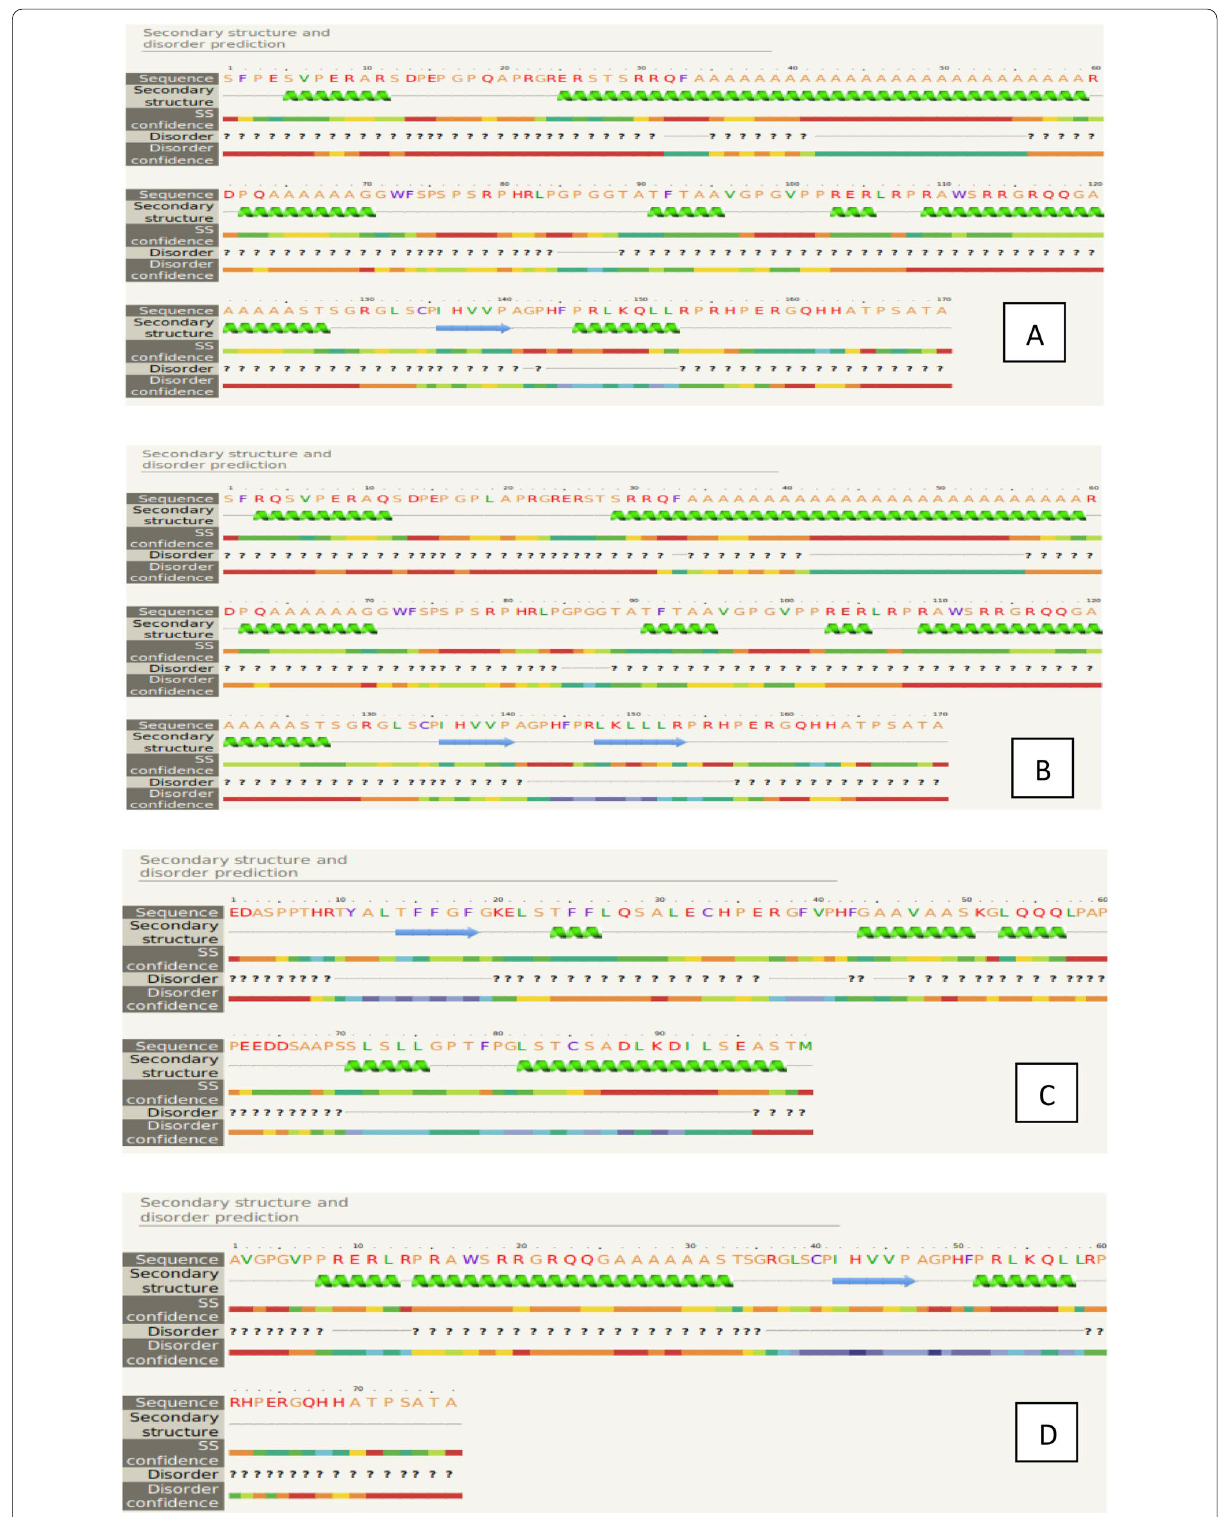
Fig. 4 Secondary structure change in protein in PCOS patients in comparison with control. A represents effect of amino acid substitution in patients with PCOS compared with control B in sequence X:67545209–67545742; C represents alteration in protein secondary structure in PCOS patients compared with control D in sequence X:67545503–67545739. Data were generated using Phyre 2 protein analysis